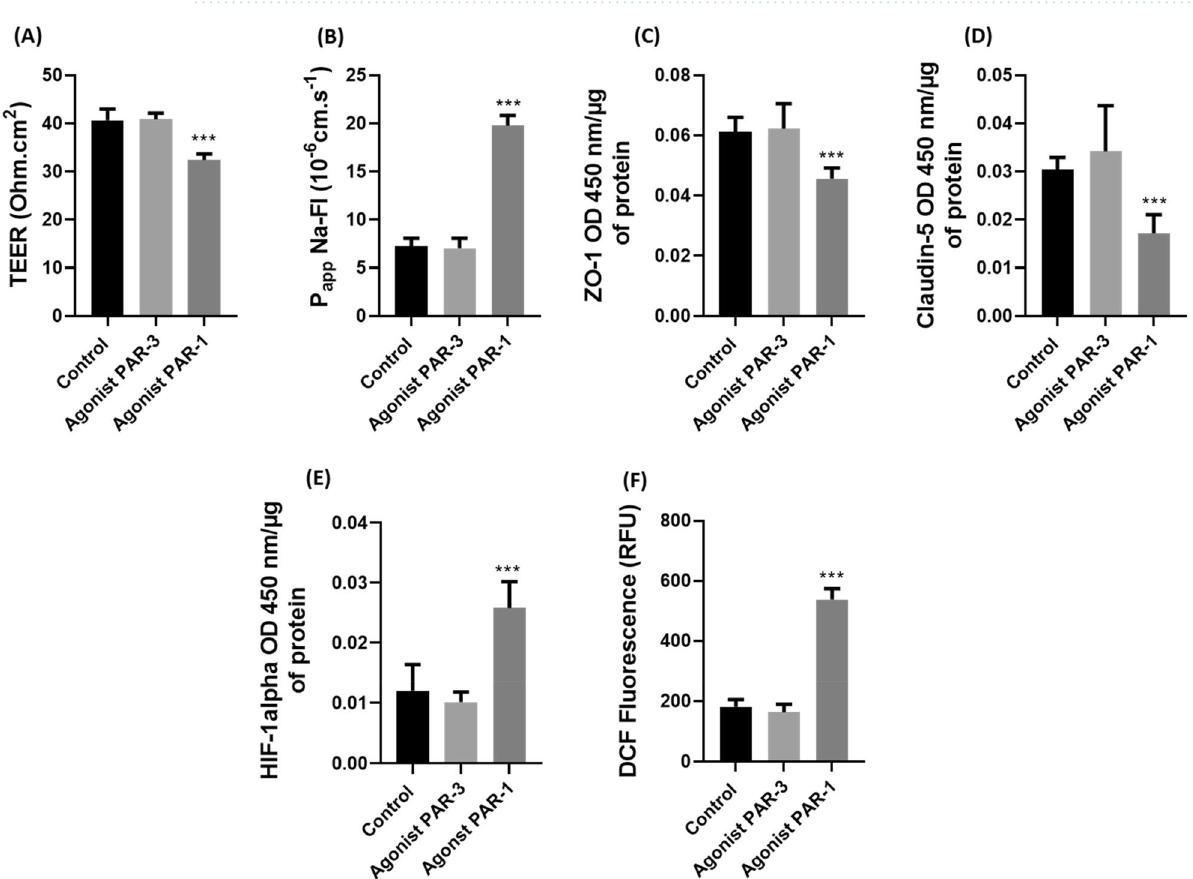
Figure 5. Evaluation of transendothelial electrical resistance (TEER) ( a ) , apparent permeability (P app ) for Na-Fl ( b ), expressions of ZO-1 ( c ), Claudin-5 ( d ), HIF-1α ( e ) and ROS production ( f ) with PAR-1 and PAR-3 agonists. Values are presented as mean value ± SD ( n = 9, N = 3), *** p ≤ 0.001 compared to control condition. PAR: protease activated